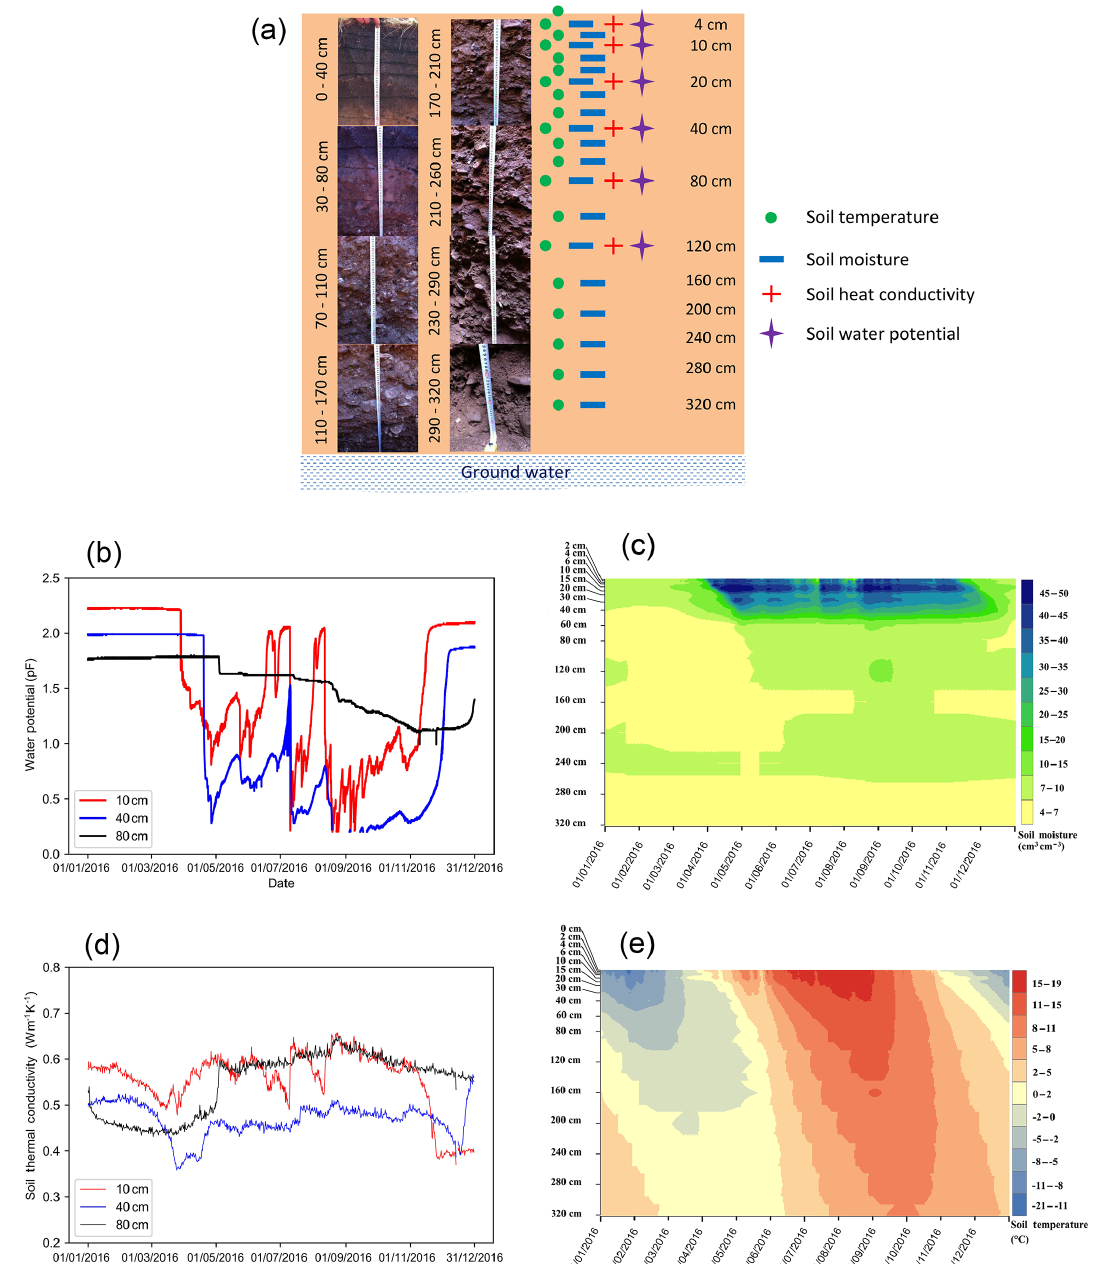
Figure 6. Frozen-ground observation at the A’rou superstation in 2016: (a) soil heterogeneity and layout of the measurements, (b) soil water potential, (c) soil moisture, (d) soil heat conductivity, and (e) soil